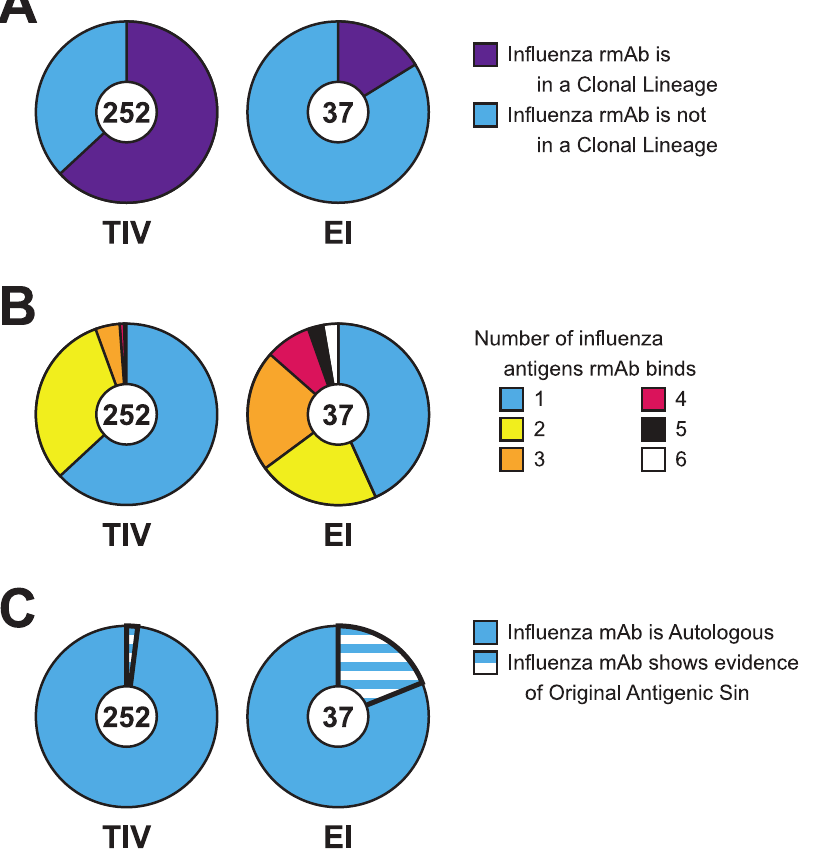
Figure 2. Characterization of influenza-specific mAbs from TIV or EI subjects. A. Clonal lineages. From TIV subjects, 159/252 (63.1%) of influenza-specific rmAbs were members of 44 clonal lineages (purple wedge); from EI subjects, 6/37 (16.2%) were members of 2 clonal lineages ( x 2 =28.9, p , 0.0001). B, Multiple reactivity to influenza antigens. From TIV subjects, 159/252 (63%) of rmAbs were strain-specific (blue wedge); multiply reactive rmAbs were less common [two antigens 79/252 (31.4%) (yellow wedge); three antigens 11/252 (4.4%) (orange wedge); four antigens 2/252 (0.8%) (red wedge); five antigens 1/252 (0.4%) (black wedge)]. From EI subjects, 16/37 (43.2%) were strain-specific ( x 2 =7.74, p =0.0054); multiply reactive mAbs were more common [two antigens 8/37 (21.6%); three antigens 8/37 (21.6%); four antigens 3/37 (8.1%); five antigens 1/37 (2.7%); six antigens 1/37 (2.7%) (white wedge)]. C. Original antigenic sin rmAbs. From TIV subjects, 5/252 (2%) of influenza-specific rmAbs did not react with strains contained in the administered vaccine but only with previously circulating influenza antigens (striped wedge). From EI subjects, 7/ 37 (19%) of influenza-specific rmAbs did not react with the infecting strain but only with previously circulating antigens ( x 2 =19.2, p , 0.0001).